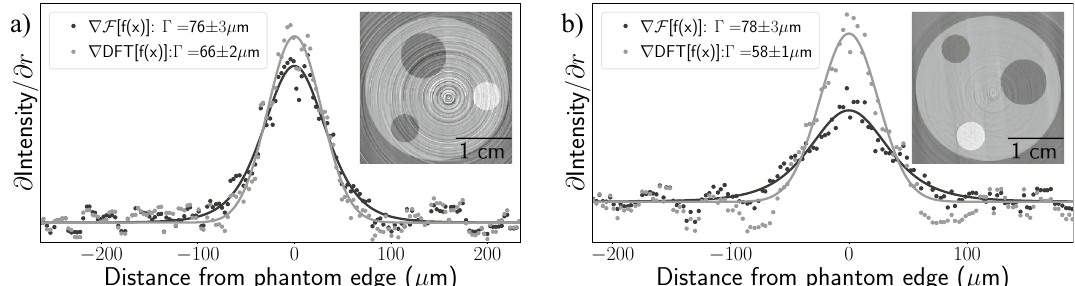
Figure 7. PSF comparison of the dual-energy phase retrieval images showing reconstructed slices of electron density maps shown in the graph inset. PSFs have been fit with Pearson VII functions for quantifying the PSF FWHM. ( a ) Shows a spatial resolution improvement of 16 ( 6 ) % at 1 m propagation distance, while ( b ) shows the same phantom at 2 m propagation distance showing a 29 ( 2 ) % improvement, likely due to the higher SNR afforded by low-pass filtering in the phase retrieval